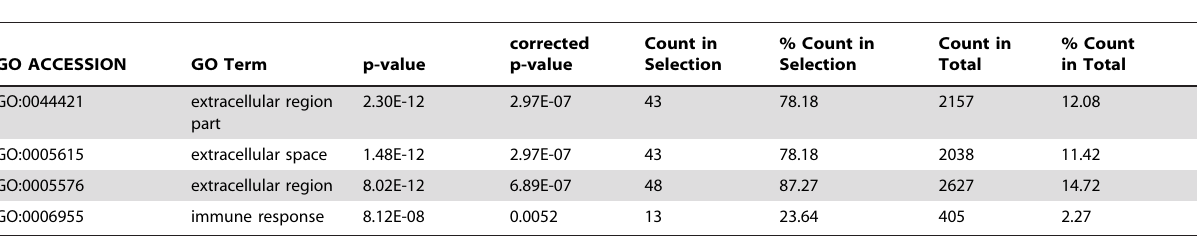
Table 7. GO Analysis of the bona fide Mta1 regulated genes in the presence of P53 with $ 2.0 fold